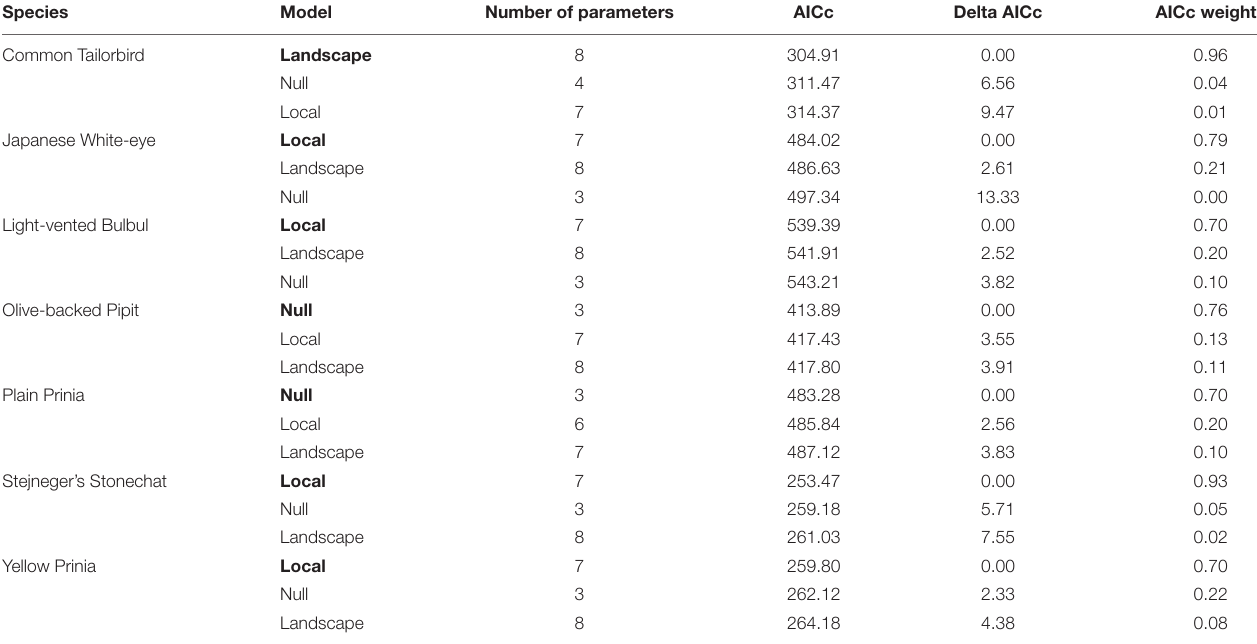
TABLE 2 | Comparisons of three abundance models for each species based on AICc.